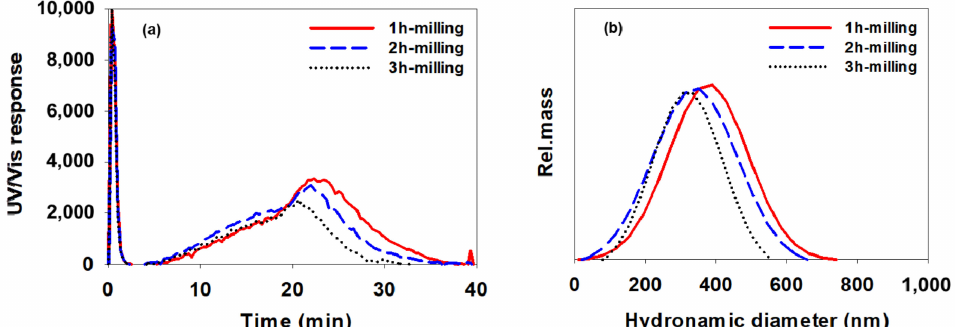
Figure 11. AsFlFFF fractograms ( a ) and size distributions ( b ) of the CB dispersions prepared with SMA-2000. All AsFlFFF conditions were the same as those in Figure